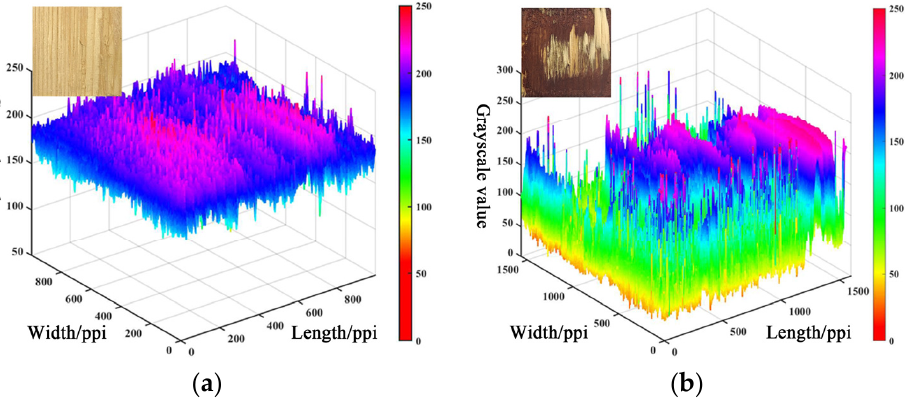
Figure 11. Local pixel value changes before and after failure of the base material: ( a ) Natural larch; ( b ) Larch after failure; ( c ) Natural carbonized bamboo; ( d ) Carbonized bamboo after failure.WOM.